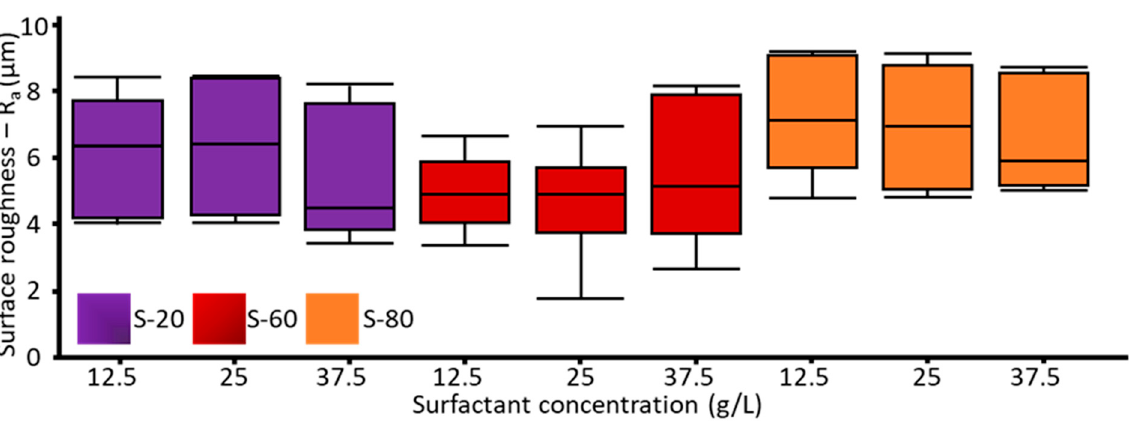
Figure 13. The parametric trend of surface roughness concerning surfactant type and concentra- tion.